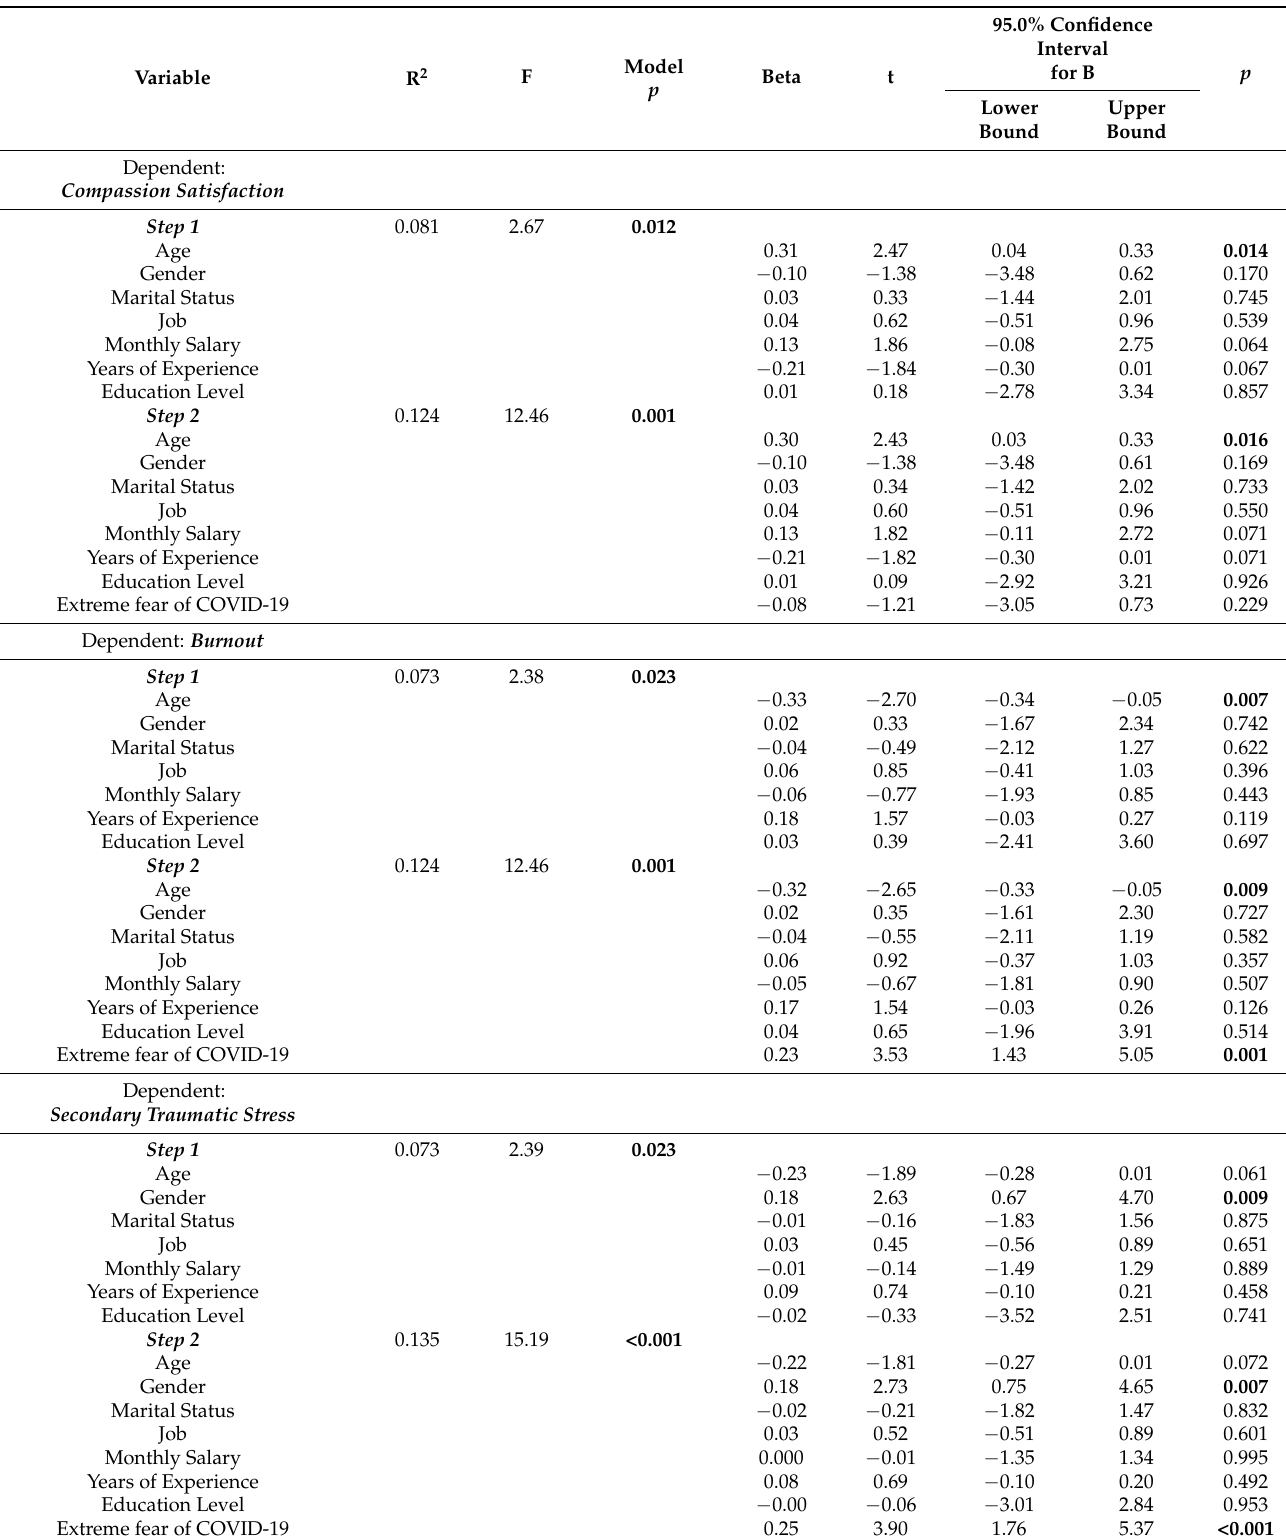
Table 3. The effect of extreme FCV-19 on ProQOL dimensions in MHWs controlling for sociodemo- graphic and professional factors. Hierarchical linear